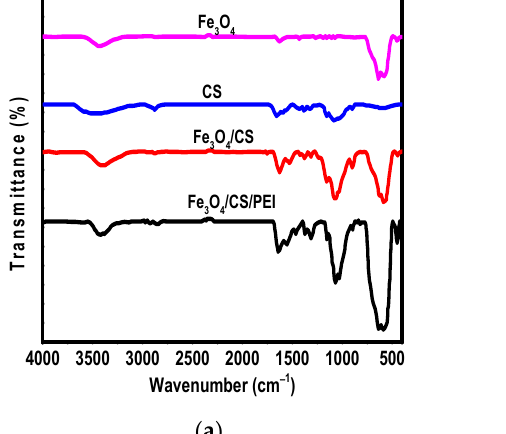
3 O 4 , Fe 3 O 4 /CS, and Fe 3 O 4 /CS/PEI mag-